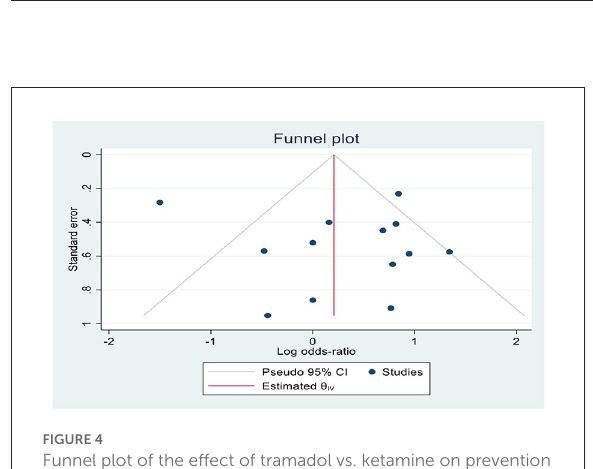
FIGURE4 Funnel plot of the effect of tramadol vs. ketamine on prevention of